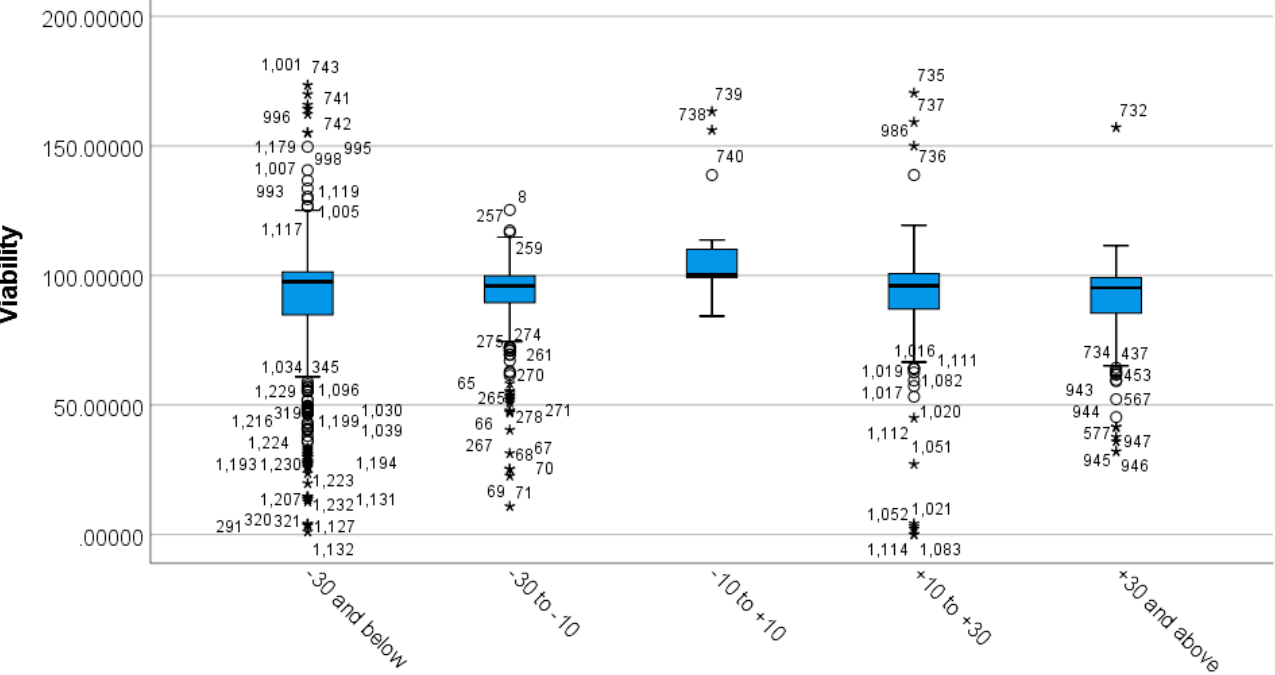
Figure 6. Distribution of viability across different MSN zeta ‐ potential groups . The boxplot shows the distribution of viability across different MSN zeta ‐ potential groups. Any data points that are more than 1.5 box ‐ lengths from the edge of their (blue) box are classified by SPSS Statistics as outliers and are illustrated as circular dots. Any data points that are more than 3 box ‐ lengths away from the edge of their box are classified as extreme points (i.e., extreme outliers) and are illustrated with an asterisk (*).